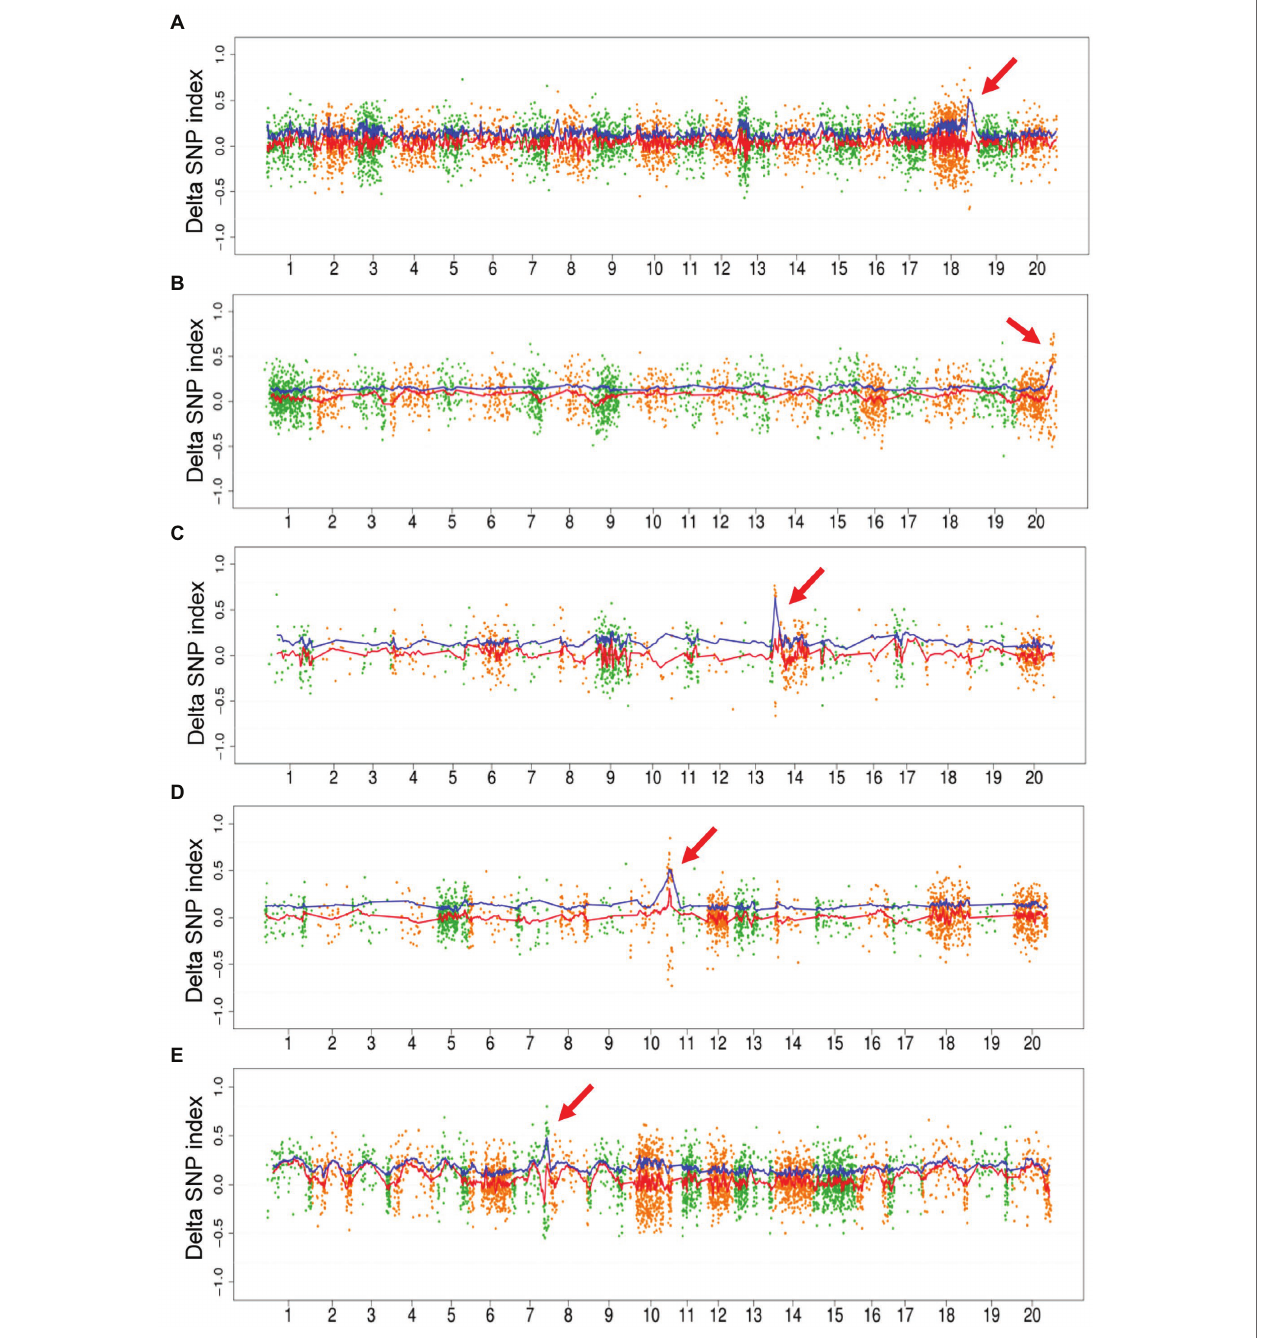
FIGURE 3 | Plot of M2-seq mapping of five M 2 populations. The M 2 populations included Mut03 (A) , Mut05 (B) , Mut06 (C) , Mut07 (D) , and Mut10 (E) . Each point represents a single-nucleotide variant (SNV), the red line is the fitted curve of delta SNP index (DSI), and the blue line is the fitted curve of absolute value of DSI (ADSI). The red arrows indicate the candidate regions detected by the curve of